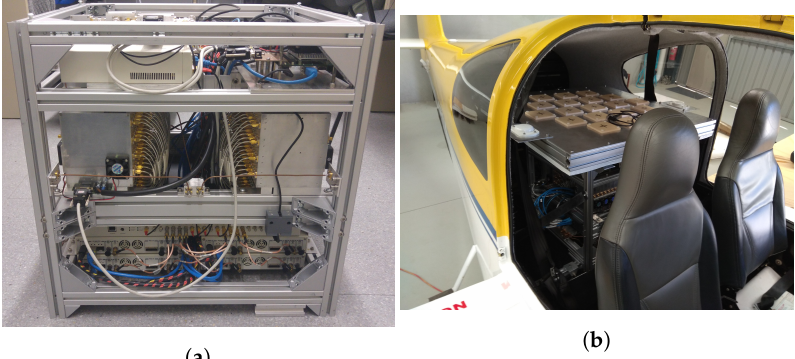
Figure 1. ( a ) MIR instrument, and ( b ) 19-element up-looking antenna array mounted in a fixed-wing